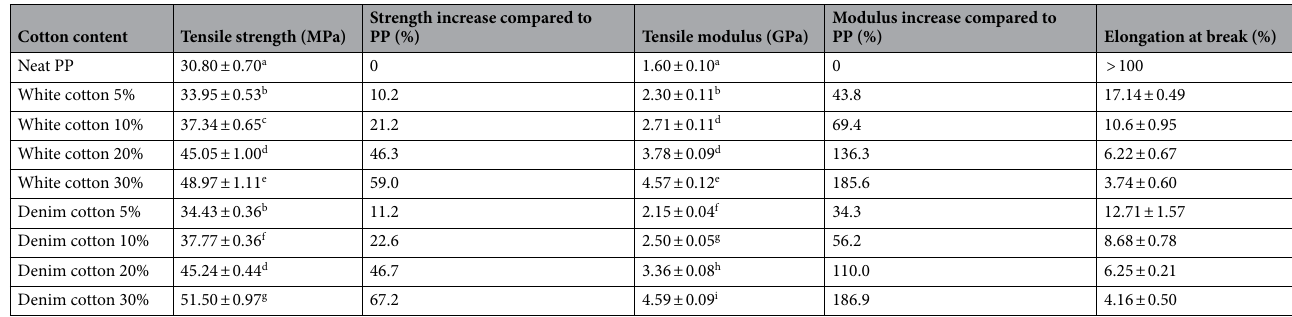
Table 1. Tensile properties of cotton/PP composites with different cotton loadings. Different letters indicate significant differences (p < 0.05) using Students’ t-test for strength and